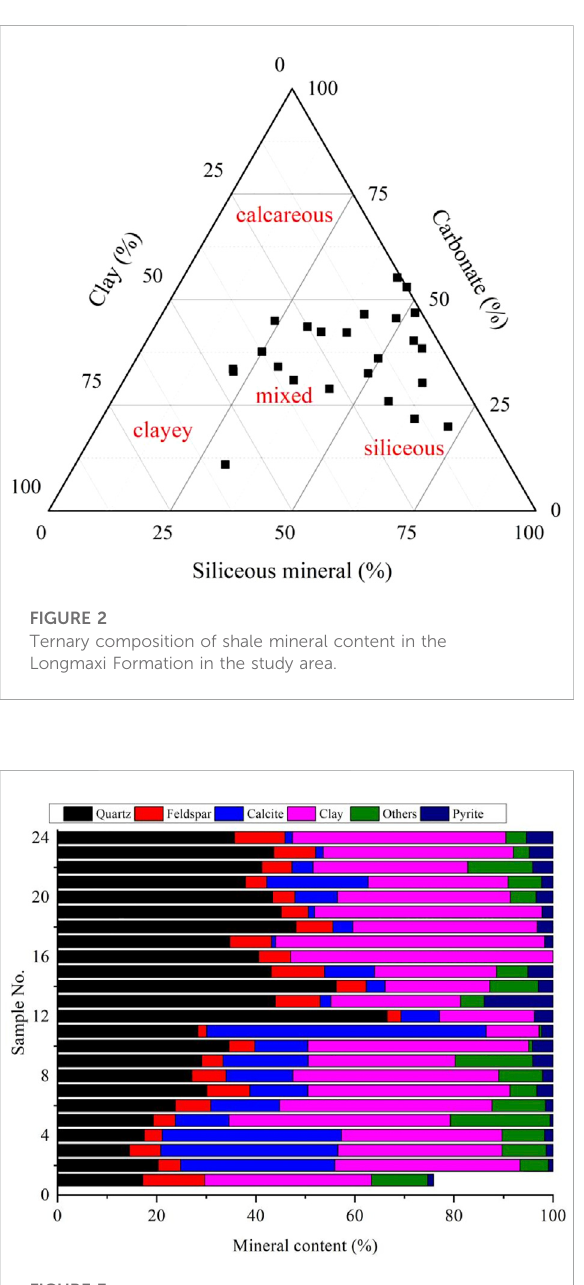
FIGURE 3 Distribution characteristics of whole-rock mineral content in the Longmaxi Formation shale in the study area.